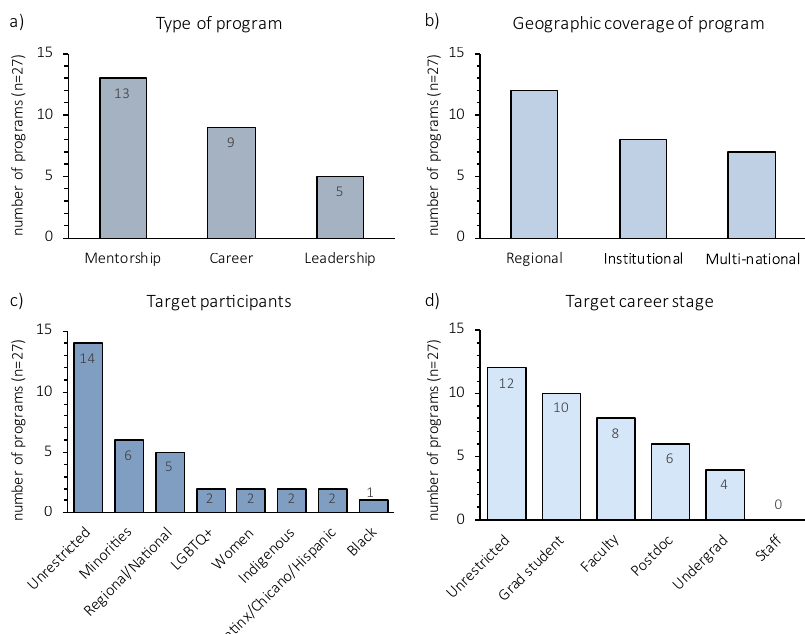
Fig. 1 Attributes of career development, leadership and mentorship programs from around the world. Graphs represent the number of identi fi ed programs according to a type of program, b geographic coverage of the program, c target participants, and d target career stage. Most programs we reviewed focus on mentorship, are offered regionally, are not limited to speci fi c target groups, and emphasize faculty and postdoc career stages. Notably, no programs speci fi cally target staff (non-faculty, university employees), despite evidence that staff and contingent faculty roles (e.g., adjuncts, non- tenure-track) do extensive service in mentoring and provision of DEI services in academia. Also, most programs include multiple target categories, so totals are >n in fi gure sections c and d